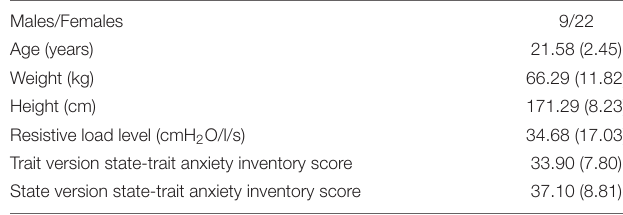
TABLE 1 | Characteristics of the